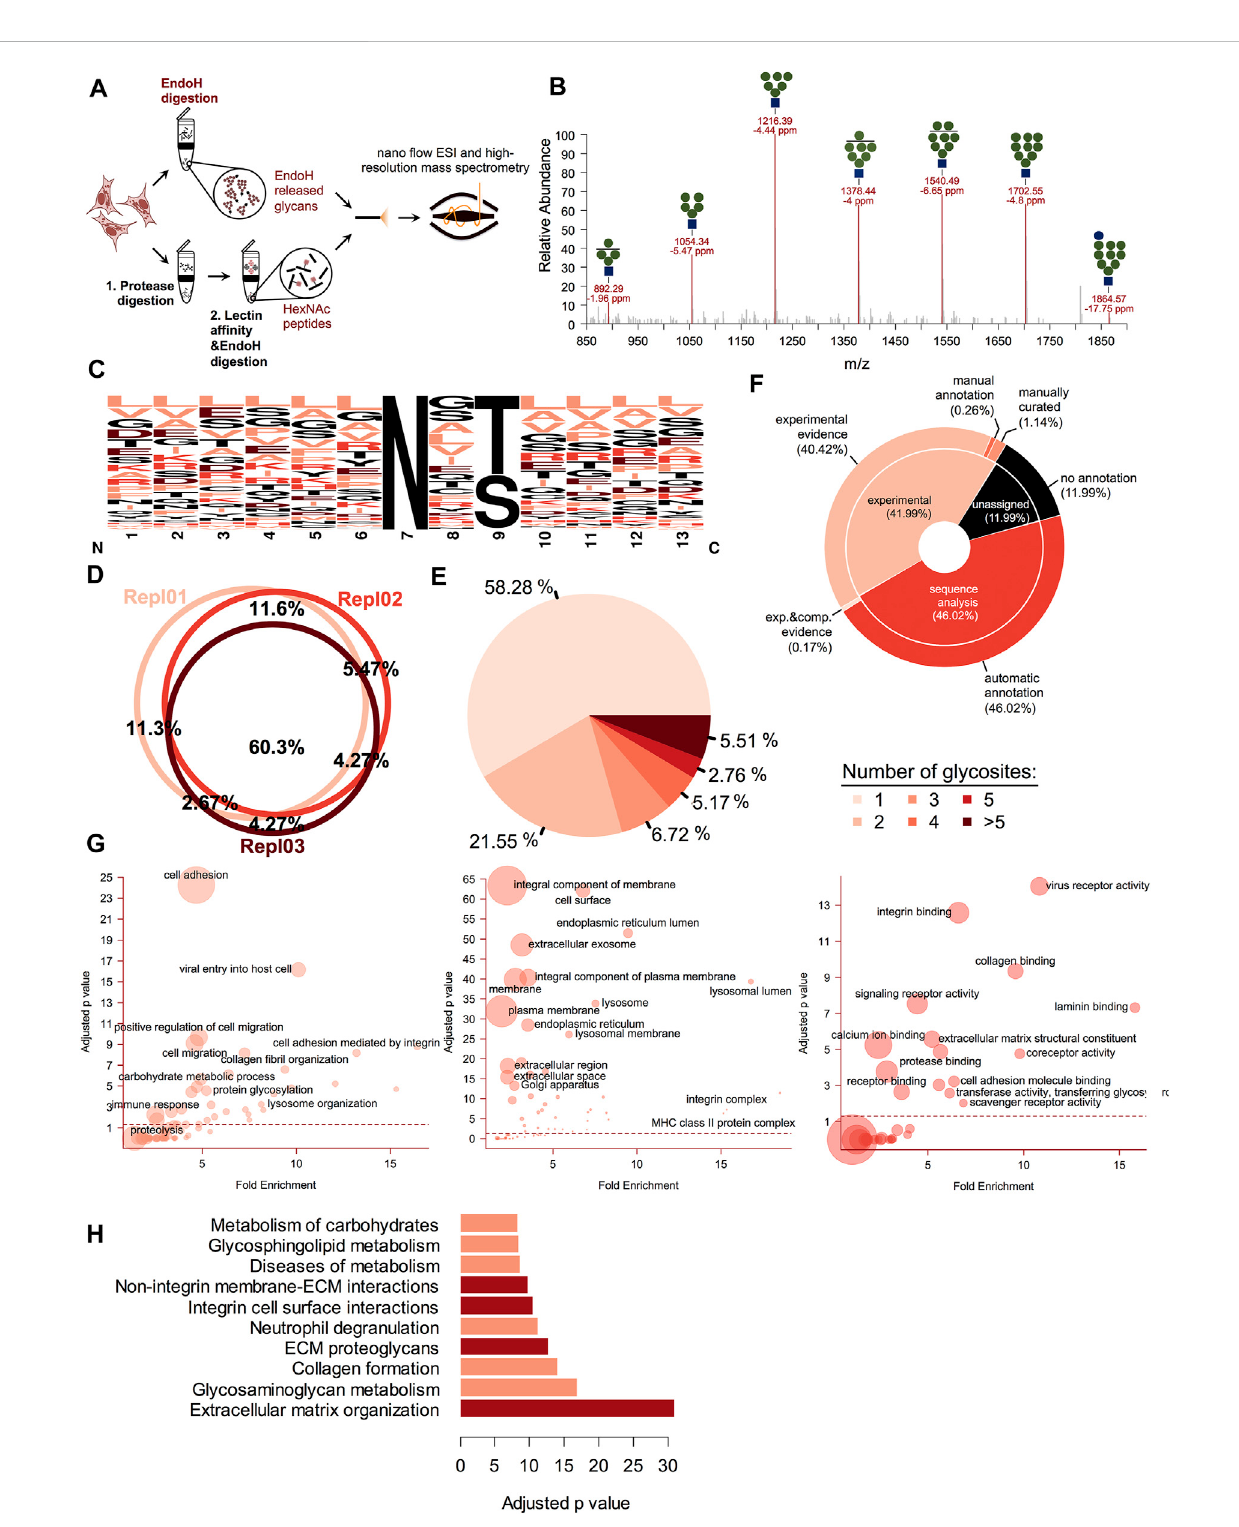
FIGURE 1 Glycoproteomic analysis of the early secretory pathway (ESP) members. (A) . Schematic illustrating the principle of the gESP work fl ow for the analysis of oligomannosidic and ESP glycoproteins. To analyze both, the carbohydrate and the protein fraction from the same sample, the extracted proteins from the biological material are split. Glycans are released using Endo H digestion and another part is subject to protease digestion 1) and the glycopeptides are enriched using lectin-af fi nity2).To obtain thesame pool ofnon-matureglycoproteins,these are furtherreleasedusing EndoH digestion. Bothfractions containingreleasedN-glycansandHexNAcpeptidesarefurtheranalyzedusinghigh-resolutionmassspectrometry(HRMS). (B). Oligomannoseglycanpro fi le obtainedfromacellularlysateofA375melanomacellssubjecttoEndoHdigestion.Thesewereidenti fi edassinglechargedsodiumadductsinnanoESIforthe fullrangefromG1M9toG0M4.Shownaretheobservedm/z,andthecalculatedmassaccuracy. (C). Sequencelogoofthecorrespondingidenti fi edglycosites. Mostoftheidenti fi edglycositescorrespondtotheN-X-T/Smotif. (D). Biologicalreplicateanalysisoftheidenti fi edglycosites.Morethan60%oftheglycosites arereproducibleidenti fi ed. (E). Glycositedistributionanalysisacrosstheidenti fi edglycoproteins. (F). UniProtKBannotationoftheidenti fi edglycositesforeach